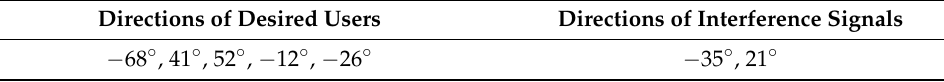
Table 2. The directions of the desired users and interference signals. Directions of Desired